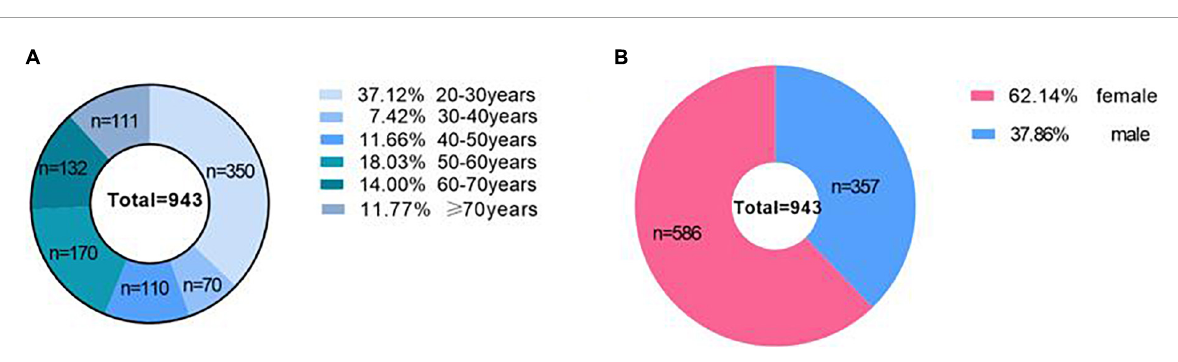
PD value prediction model; (4) the T1 value combined with the T2 value prediction model; (5) the T1 value combined with the PD value prediction model; (6) the T2 value combined with the PD value prediction model; and (7) the T1 value, T2 value, and PD value joint prediction model. The